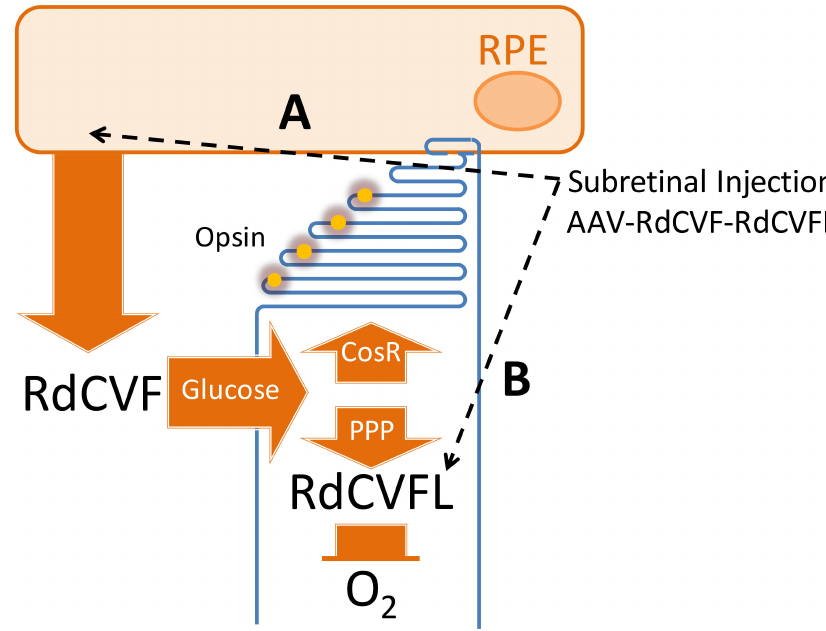
Figure 1. Subretinal injection of AAV-RdCVF-RdCVFL to prevent the loss of function of cones in retinitis pigmentosa, ( A ) Transduction of the drug (recombinant AAV) to the retinal pigmented epithelium, expression and secretion of RdCVF to stimulate glucose entry, cone outer segment renewal (CosR) and the pentose phosphate pathway (PPP). ( B ) Transduction of the drug (recombinant AAV) to the cones and stimulation of redox homeostasis through NADPH, reduced by the metabolism of glucose through the pentose phosphate